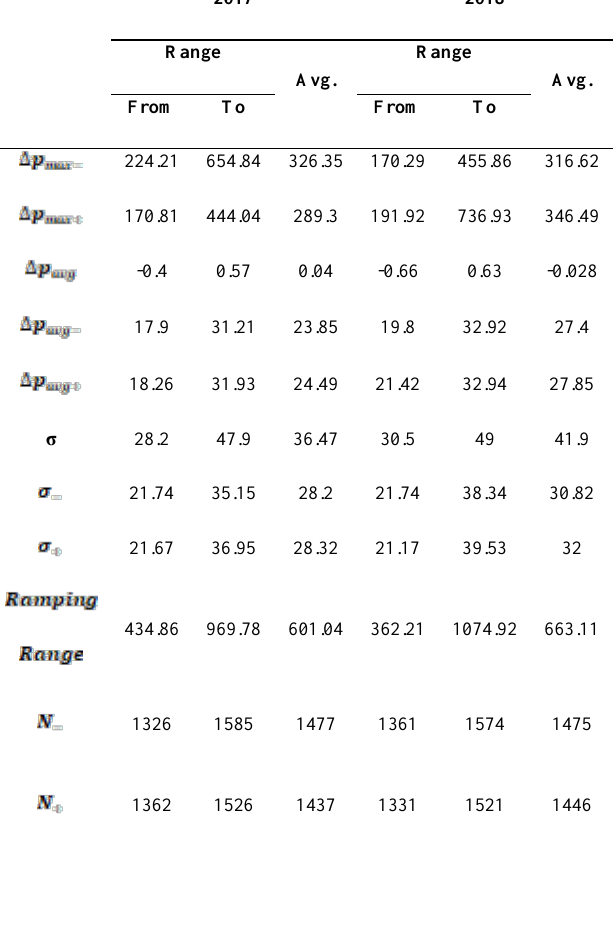
Table 3 . Horizontal analysis results